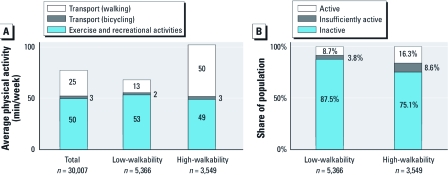
Differences among neighborhoods. (A) Average active transport (minutes walking and bicycling per person) and recreational activities. (B) Physical activity levels. The between-neighborhood difference in total physical activity is statistically significant (p < 0.001, two-tailed t-test).